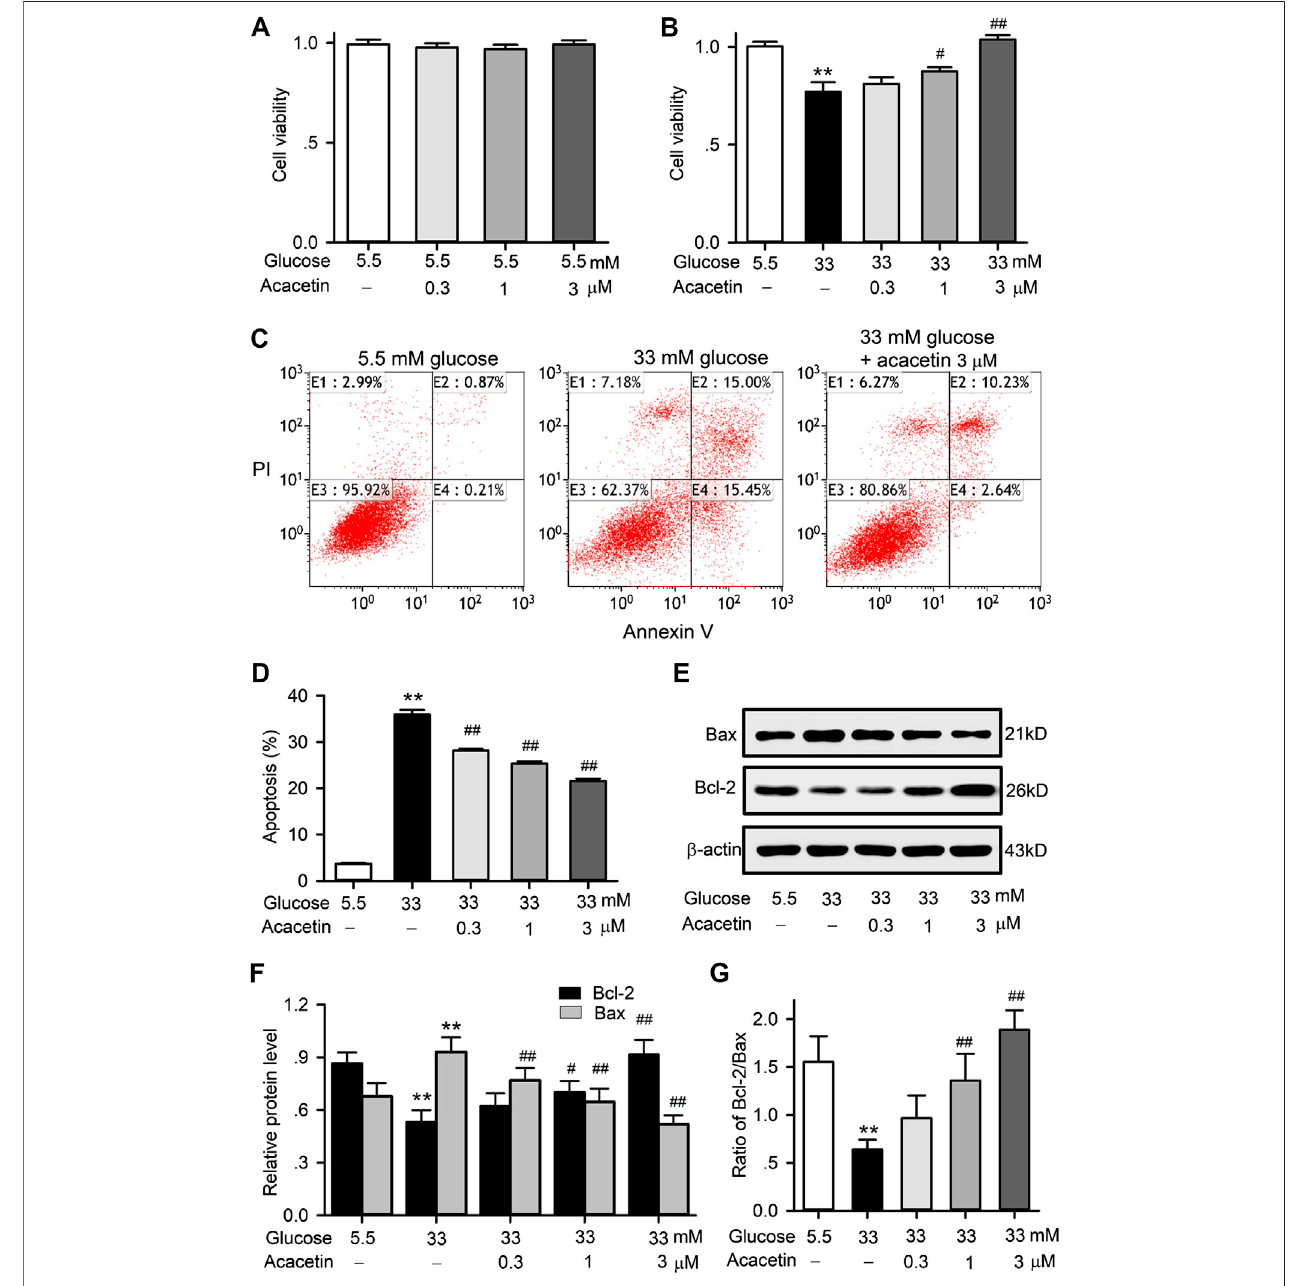
FIGURE 1 | Effects of acacetin on cell viability and apoptosis induced by high glucose exposure in HUVECs. (A) Acacetin had no effect on cell viability in HUVECs cultured with 5.5 mM glucose medium. (B) Acacetin countered viability reduction induced by high glucose medium culture in a concentration-dependent manner. (C) Flow cytometry graphs for cell apoptosis (E2 + E4) in cells cultured with 5.5 mM or 33 mM glucose medium, or 33 mM glucose plus 3 μ M acacetin. (D) Acacetin decreased apoptosis induced by high glucose culture in a concentration-dependent manner. (E) Western blots of apoptosis-related proteins Bax and Bcl-2 in HUVECs culture with 5.5 mM glucose or 33 mM high glucose, or 33 mM glucose with 0.3, 1 and 3 μ M acacetin. (F) Acacetin reversed the Bax increase and Bcl-2 decreaseinducedbyhighglucosecultureinaconcentration-dependentmanner. (G) AcacetincounteredthedecreasedratioofBcl-2/Baxinaconcentration-dependent manner. n (cid:2) 5 individual experiments, ** p < 0.01 vs. 5.5 mM glucose; # p < 0.05, ## p < 0.01 vs. 33 mM glucose).